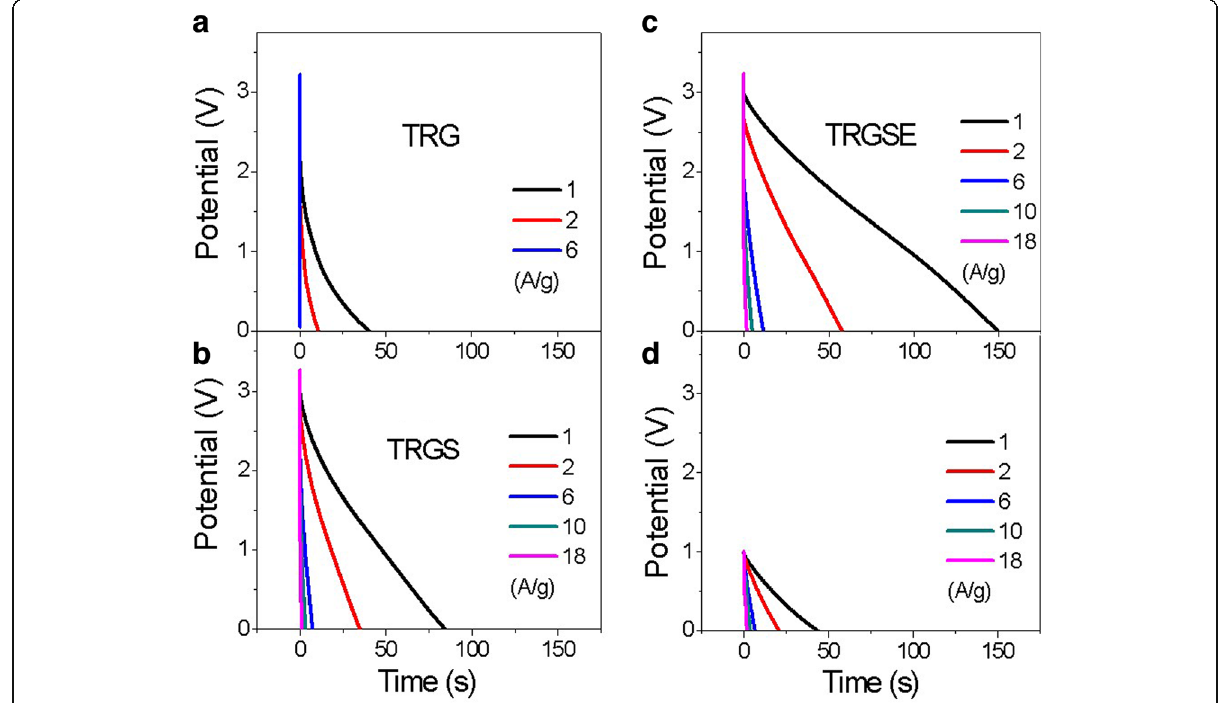
Fig. 8 The galvanostatic discharge response vs. time for the a TRG, b TRGS, and c TRGSE cells using IL electrolyte, and d the TRGSE cell using 2 M H 2 SO 4 as